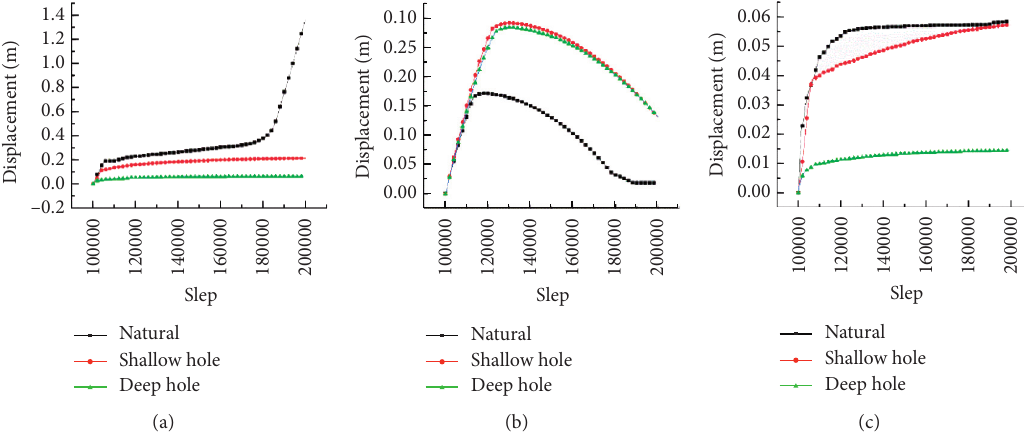
Figure 13: Surrounding rock displacement curve in different grouting methods: (a) Roof; (b) floor; and (c) two